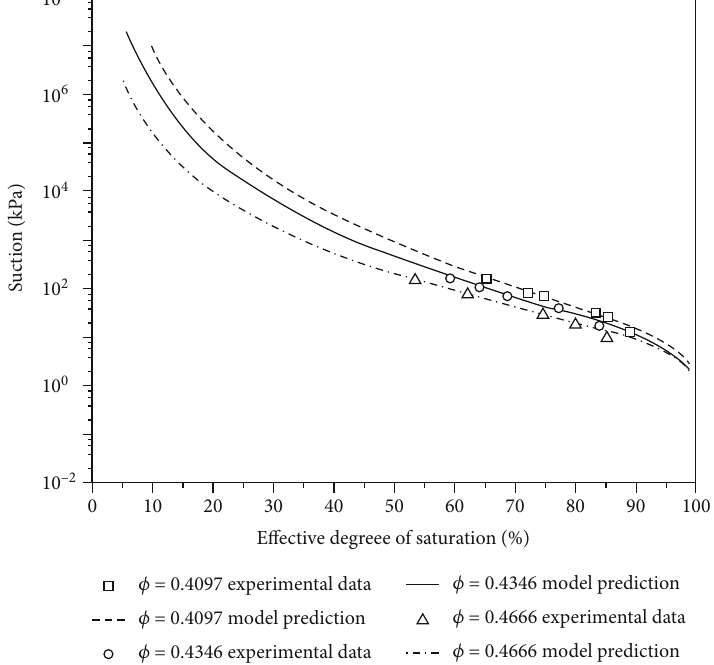
Figure 6: Comparison between experimental and predicted SWRCs with di ff erent porosities.